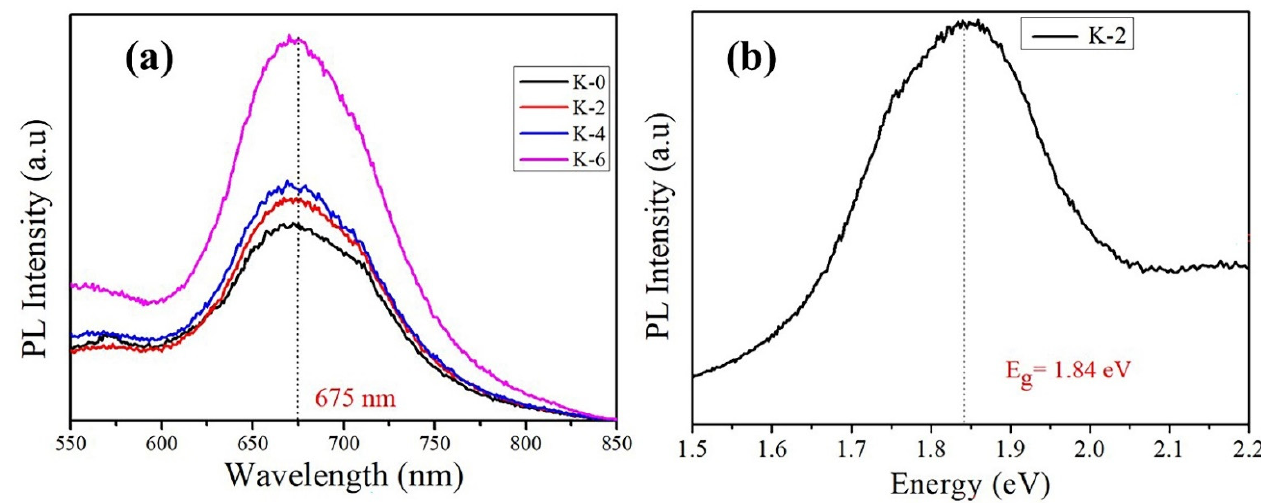
Figure 7. ( a ) Cs 3 Bi 2 I 9 perovskite device PL steady-state measurement spectra K-0, K-2, K-4, and K-6. Figure 7. ( a ) Cs ₃ Bi ₂ I ₉ perovskite device PL steady-state measurement spectra K-0, K-2, K-4, and K-6. ( b ) The PL spectra energy curve for the campion device K-2. ( b ) The PL spectra energy curve for the campion device